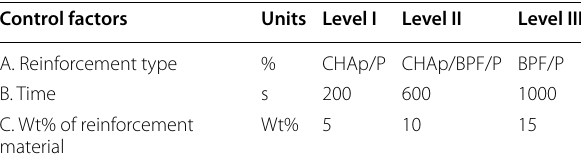
Table 6 Levels of various control factors